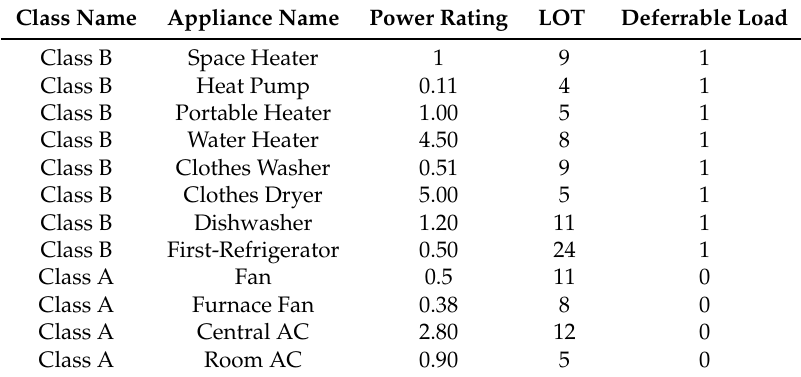
Table 9. Parameters and power ratings.